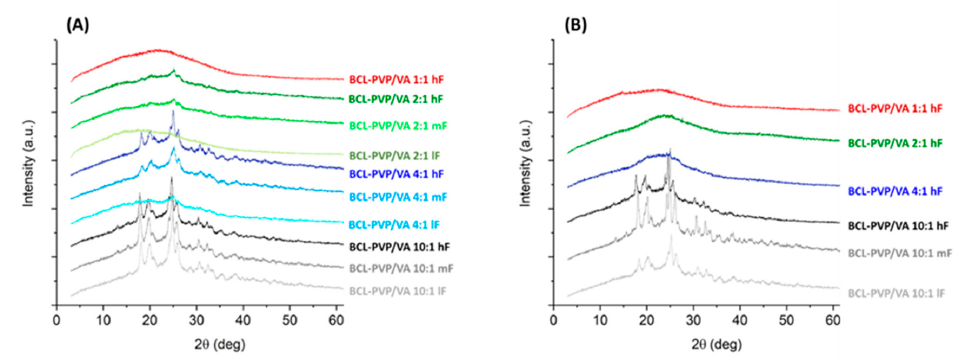
Figure 10. X-ray di ff raction patterns of tablets containing BCL-PVP / VA solid dispersions obtained by either ball milling ( A ) or spray drying ( B ). hF, mF, and lF represent high, medium, or low compression force, respectively.